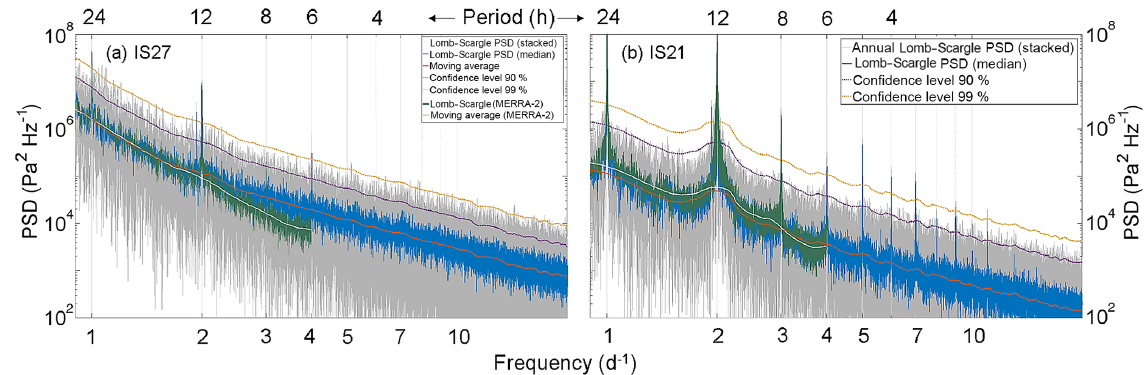
Figure 9. Lomb–Scargle PSD curves for (a) IS27 (Antarctica) and (b) IS21 (Marquesas Islands). The peaks closely left of the predominant semi-diurnal peak are related to the lunar day. This peak is not present in MERRA-2 reanalysis.